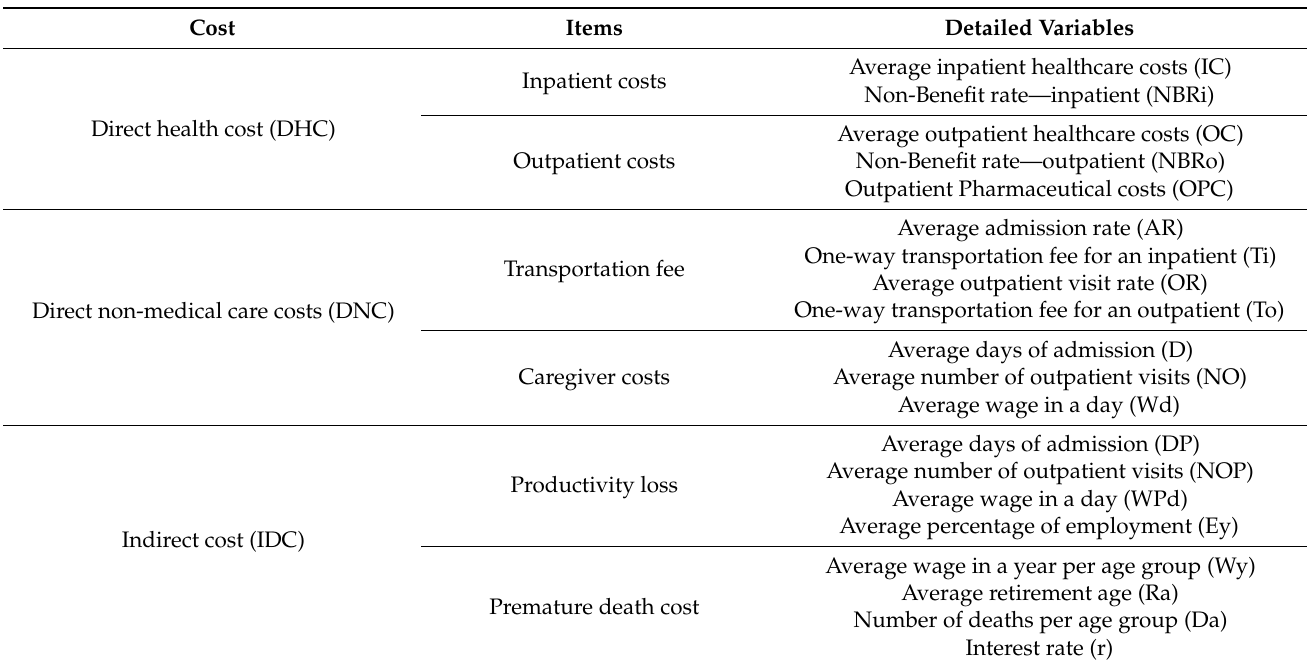
Table 1. Detailed variables and data sources per cost